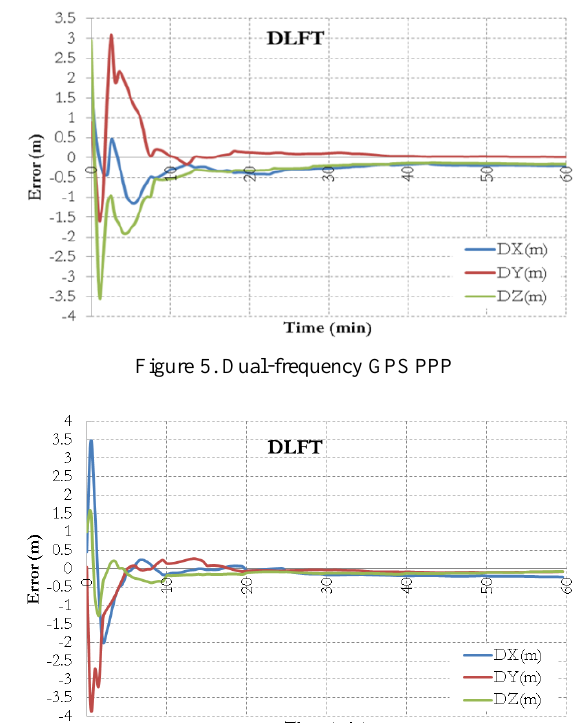
Figure 4. GPS/Galileo PPP results using the newly developed stochastic model